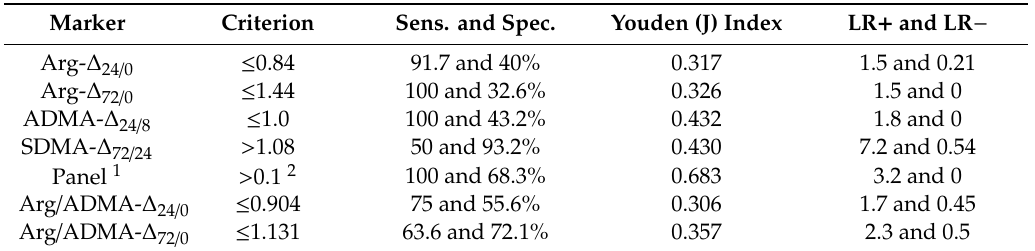
Table 12. Characteristics of L-arginine / NO pathway metabolites as predictors of surgical site infections. Marker Criterion